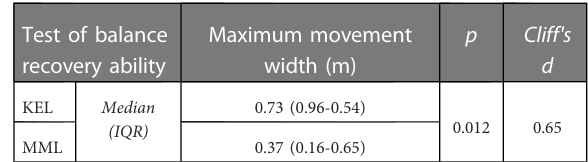
TABLE 3 The difference in maximum movement width in the test of balance recovery ability.